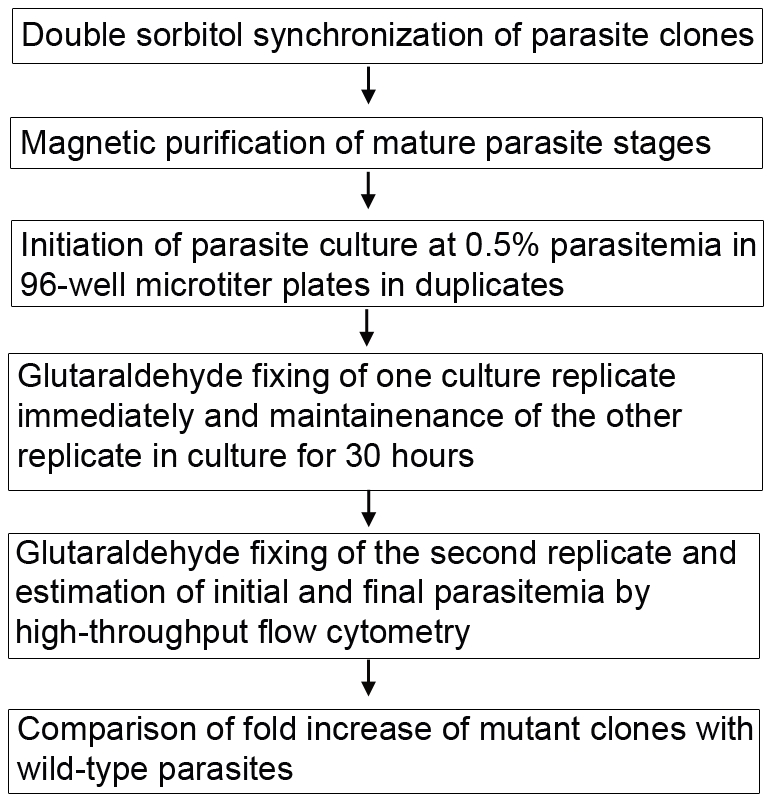
An in vitro proliferation assay for Plasmodium falciparum.A flowchart of steps involved in the in vitro proliferation assay for Plasmodium falciparum intraerythrocytic stages.